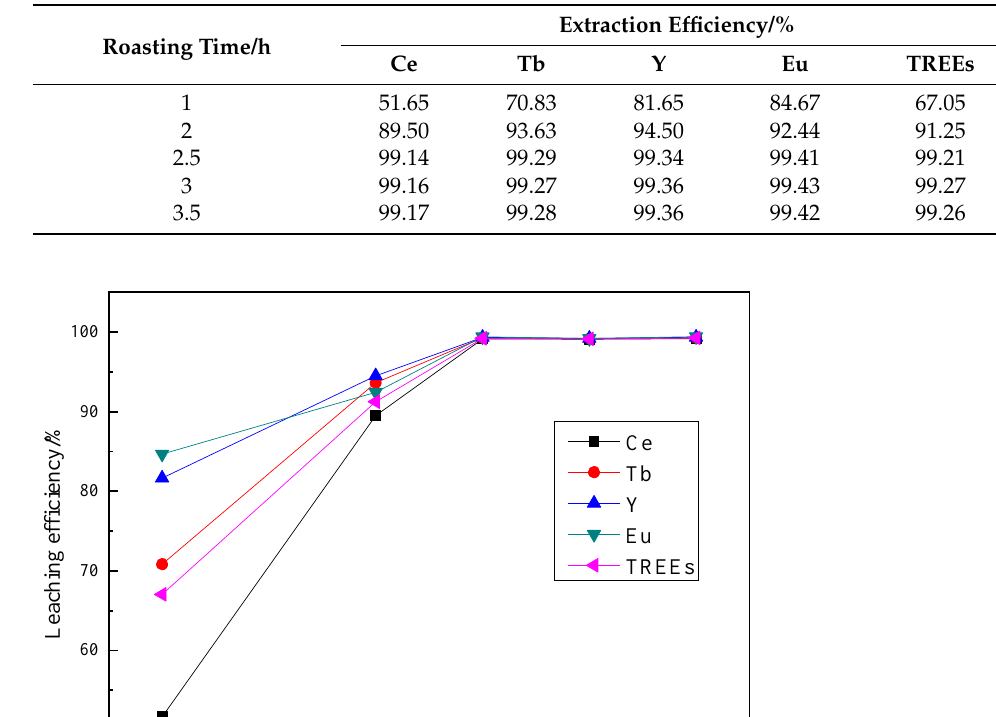
Table 4. Extraction efficiency of Ce, Tb, Y, Eu, and total rare earth under different roasting times (oxygen concentration in the mixed gas of 0.4%, a roasting temperature of 700 °C, a mass ratio of phosphor powder to alkali 1:3, a HCl solution concentration of 8 mol · L − 1 , an acid immersion